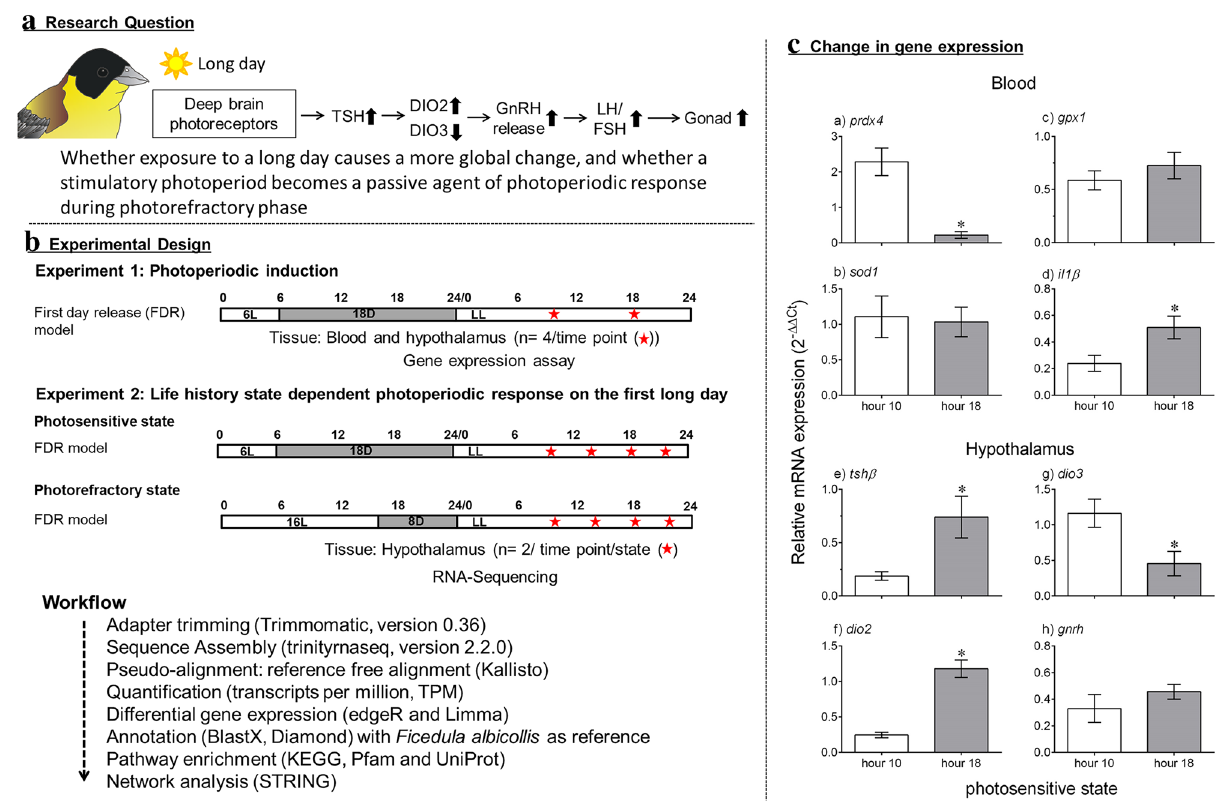
Figure 1. Left panel: ( a ) Research Question. ( b ) Shows the experiment design. In experiment 1, blackheaded buntings ( Emberiza melanocephala ; n = 8) were released from short photoperiods (6L:18D) into an extended light period, and sampled for blood and hypothalamus tissues at hours 10 and 18 (n = 4 per time point, hour 0 = light on) for gene expression assay to confirm the photoperiodic response. In experiment 2, photosensitive and photorefractory buntings (n = 8 each) maintained under 6L and 16L photoperiods, respectively, were released into an extended light period, and sampled for hypothalamus tissue at hours 10, 14, 18 and 22 (n = 2 per time point per group; hour 0 = light on) for RNA-Seq analysis. The sampling time points are indicated along the light period bars. A workflow for RNA-Seq analysis is also provided at the bottom. Right panel, ( c ) Mean (± SE, n = 4/time point) relative expression of genes in blood and hypothalamus of photosensitive blackheaded buntings at hours 10 and 18 on the first long day period (see above). a–d: Blood mRNA levels of prdx4 , sod1 , gpx1 and il1β genes. e-h: Hypothalamic mRNA levels of thyroid hormone responsive genes involved in photoperiodic induction ( tshβ , dio2 , dio3 and gnrh ). An asterisk (*) on bar indicates a significant difference (Student’s unpaired t-test). For significance, alpha was set at